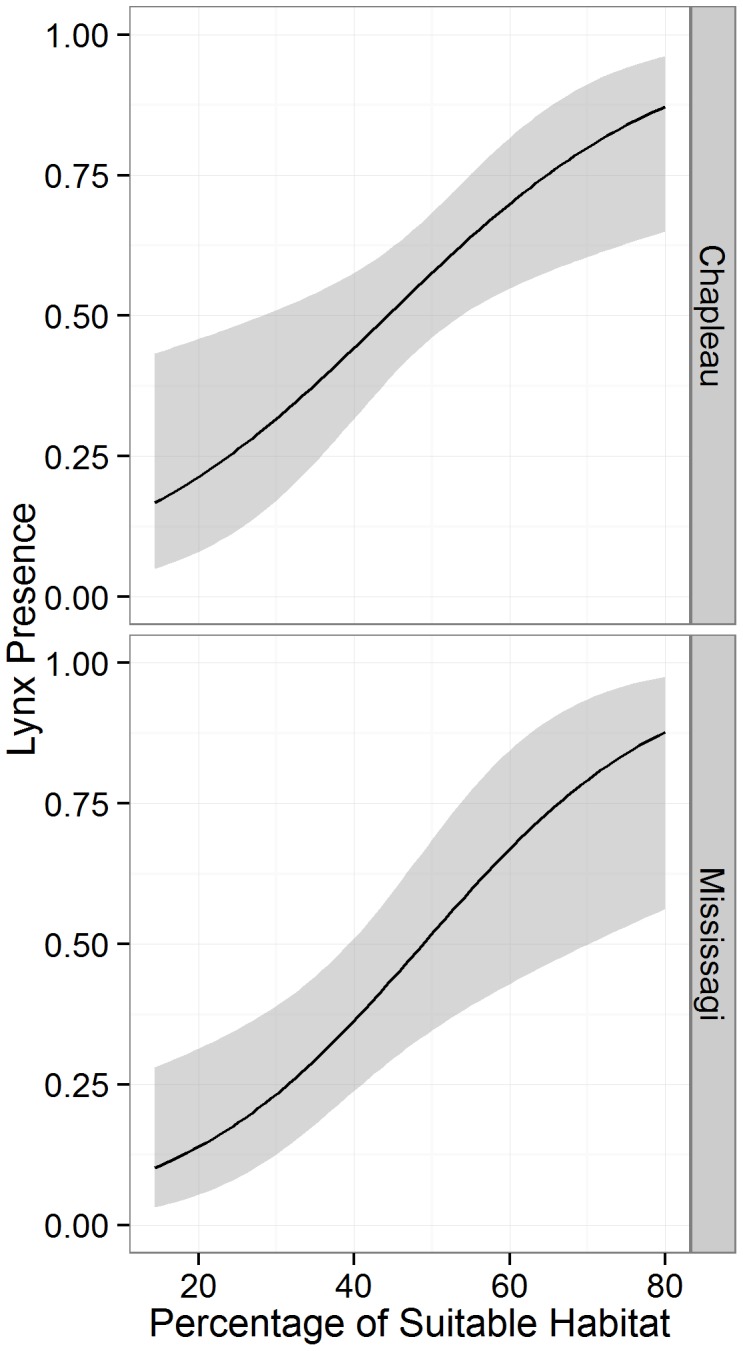
Regression plots for logistic models of Canada lynx occurrence in relation to the proportion of suitable habitat at the 25 km2 spatial scale in the Mississagi and Chapleau regions with moderate levels of fragmentation.The shaded area indicates the standard error.